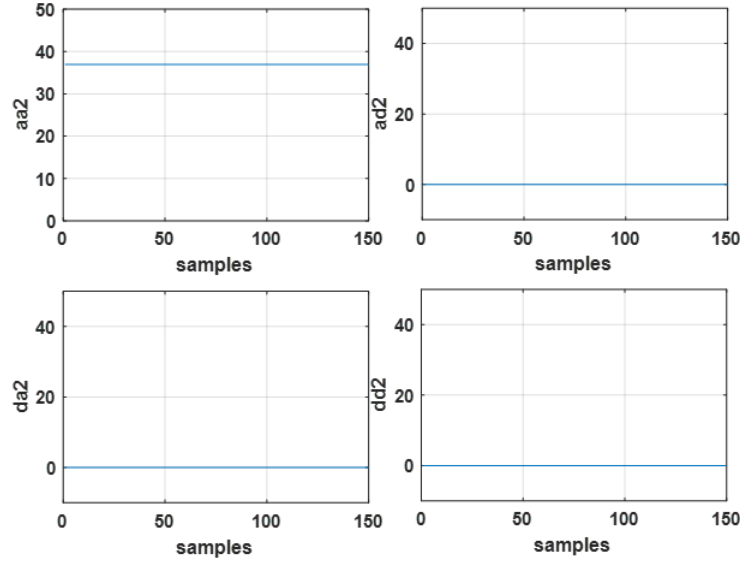
Figure 14. The 2nd level WPT-coefficients for healthy condition.